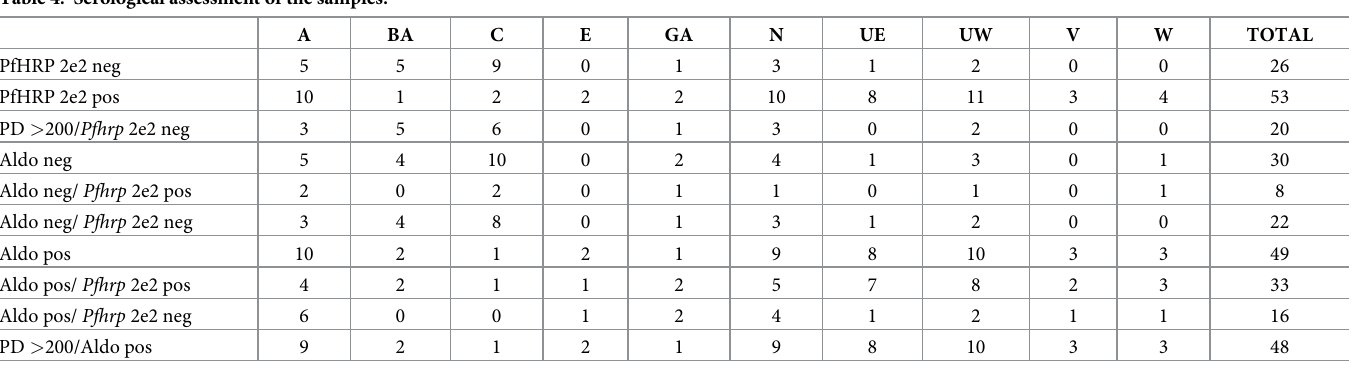
Table 4. Serological assessment of the